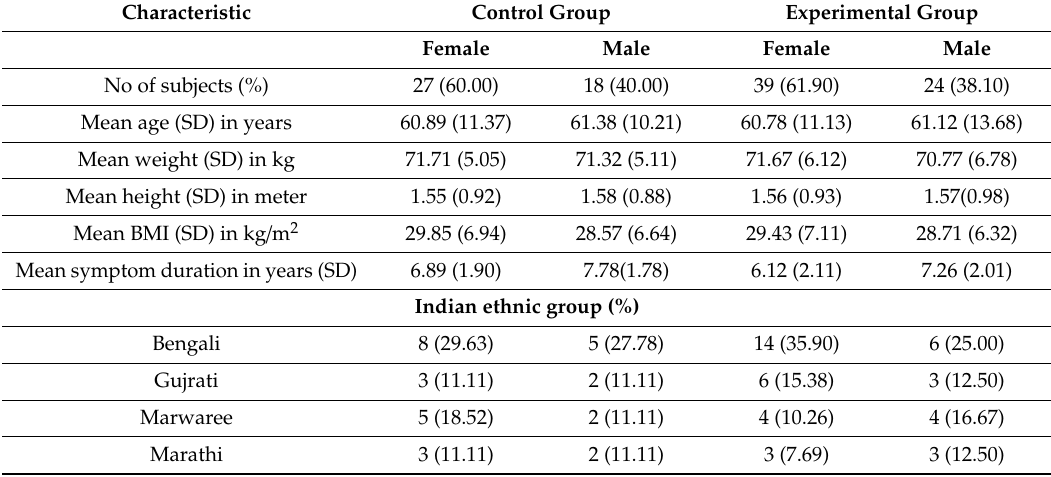
Table 1. Demographic data and baseline characteristics of the study